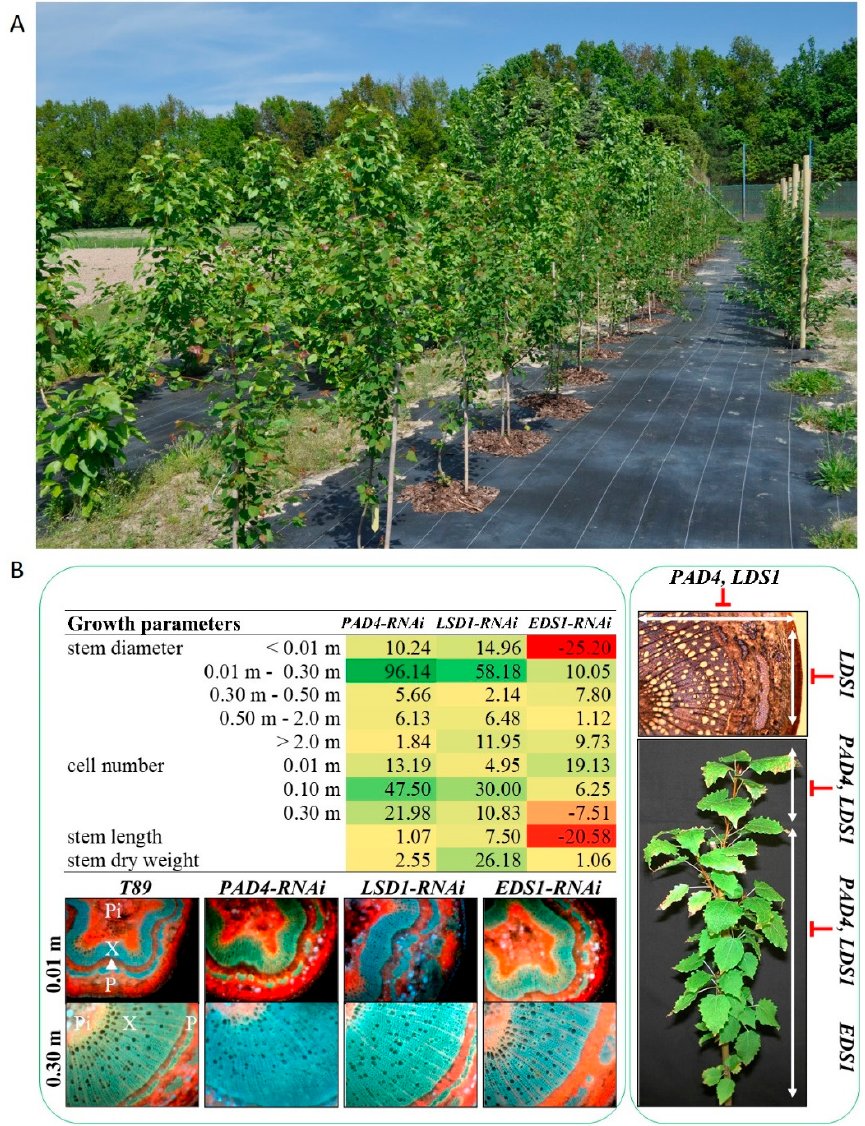
Figure 2. Photograph of transgenic poplar plantation (A), and the regulation of tree growth by LSD1, EDS1 and PAD4 (B). Percentage changes in growth parameters are presented in relation to wild-type trees (T89). Lower expression of LSD1 and PAD4 , but not EDS1 , increased biomass accumulation, measured as stem length and diameter, stem dry weight and xylem accumulation. Higher cell numbers and improved diameters were observed in young parts of the stems of PAD4 - RNAi trees, while LSD1 - RNAi trees also displayed a higher diameter of the older part of the stem, accompanied by higher stem length. Fluorescent microscopy of stem cross-sections demonstrate: Pi = pith, X = xylem; Δ = cambium, P = phloem. Based on these results the following model was suggested: PAD4 deregulates (inhibits) periclinal cell division. LSD1 has a significant effect upon both periclinal and anticlinal divisions, on cell elongation and differentiation, while EDS1 is a positive regulator of cell division and differentiation in poplars [38,48].